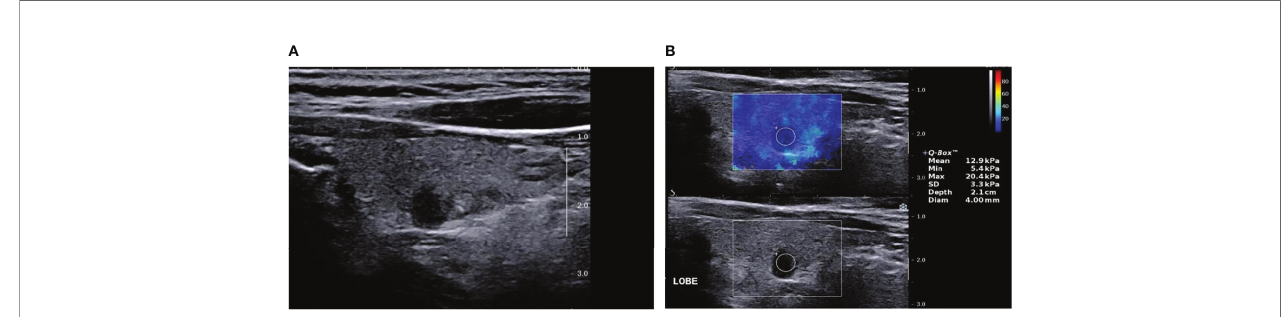
FIGURE 2 | Papillary thyroid carcinoma (SWE false-negative nodule) by two-dimensional ultrasound and elastic ultrasound. (A) A solid, very hypoechoic nodule in the middle-left lobe of the thyroid, 6.0 × 3.0 mm, with an ill-de fi ned margin and taller than wide in shape. The ACR-TIRADS score was 8 and ACR – TIRADS category was 5. (B) The Emax value of the nodule on SWE imaging was 20.4 kPa. TABLE 4 | Multiple logistic regression analysis for the SWE false positive results. Factor Group B SE Nodule size